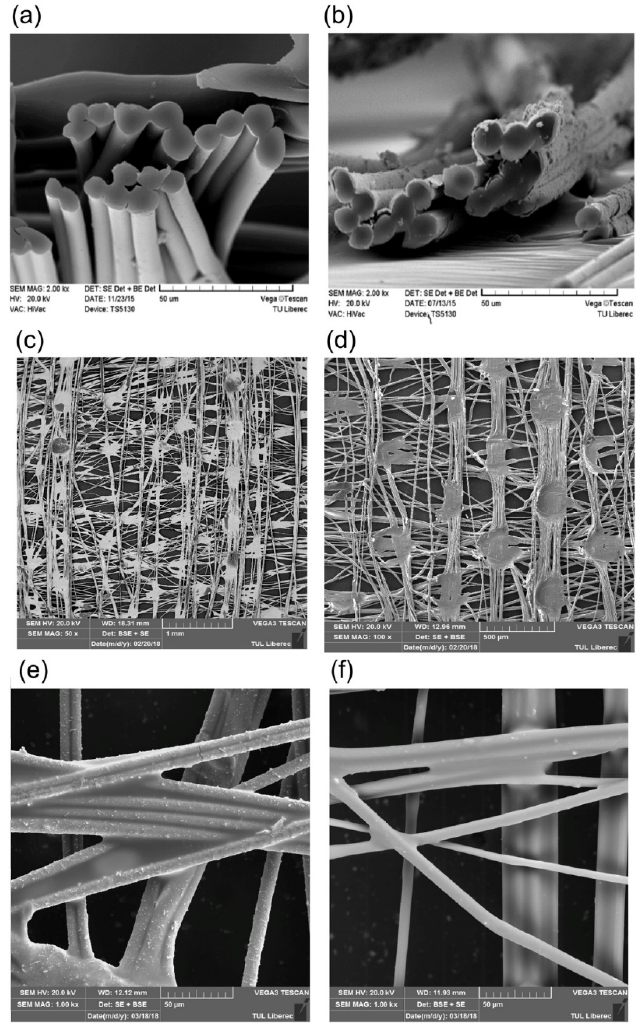
Figure 26. ( a ) Cross section views of nonmetal coated fabric; ( b ) metal coated fabric; ( c , e ) before sol-gel coating; ( d , f ) after sol-gel (PhTES) coating (Reproduced from [179], with kind permission of Elsevier).